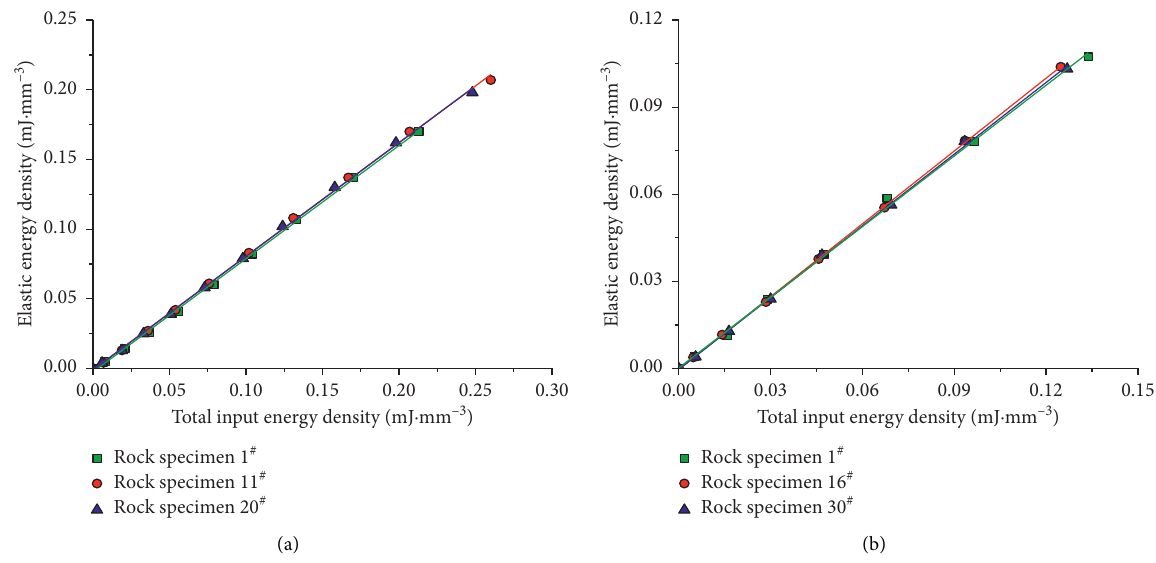
Figure 14: Relationship between the elastic and total input energy densities: (a) data from Zhang and Gao [23] and (b) Data from Meng et al.